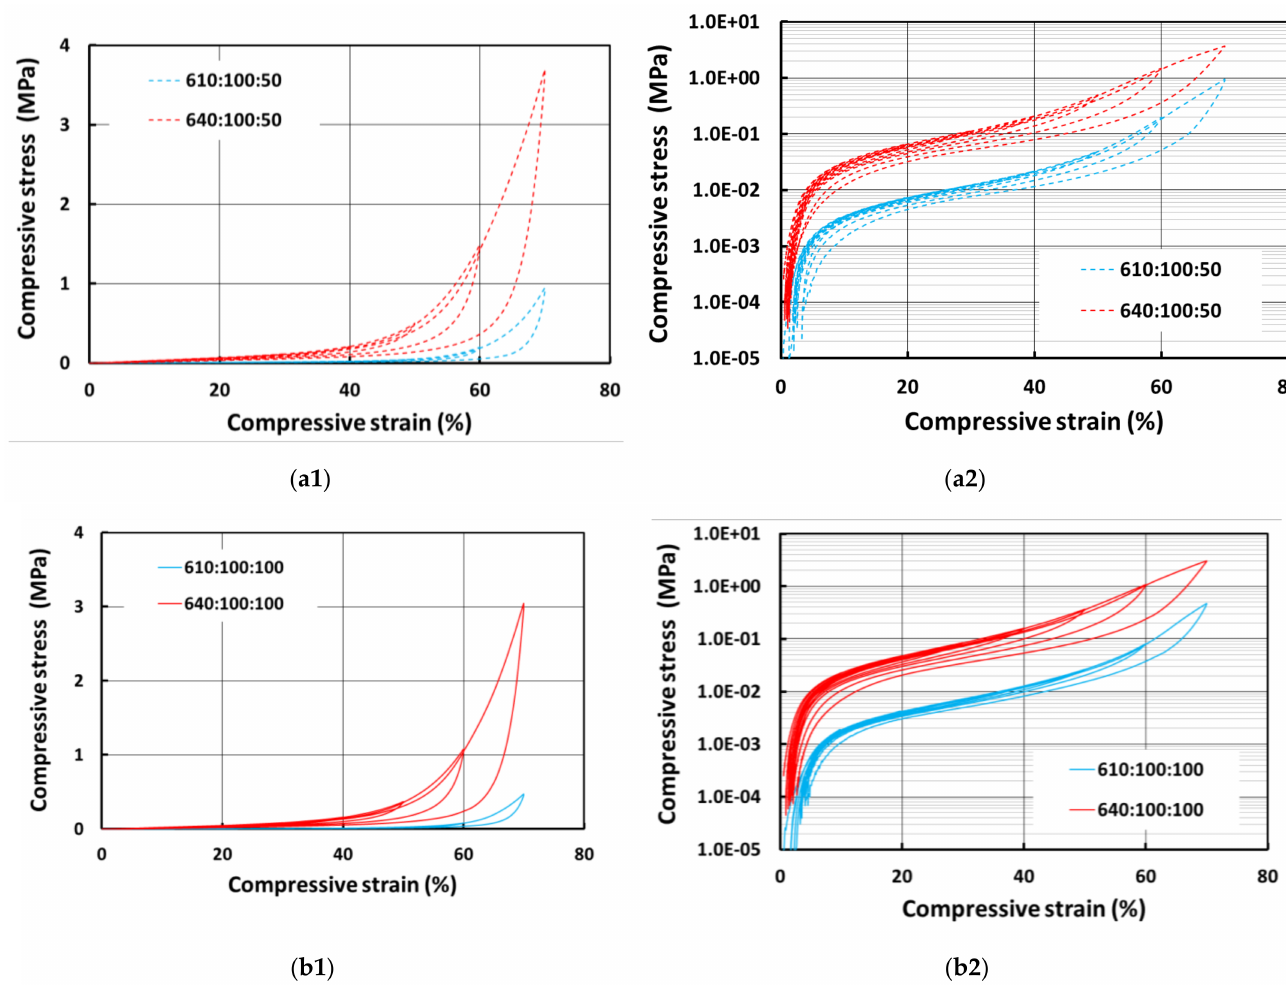
Figure 9. Stress vs. strain relationships of porous E610 and E640 samples prepared with 50% wetting hydrogel ( a1 ), its corresponding logarithmic plot of stress in ( a2 ) and 100% wetting hydrogel ( b1 ) in cyclic uniaxial compression and its corresponding logarithmic plot of stress in ( b2